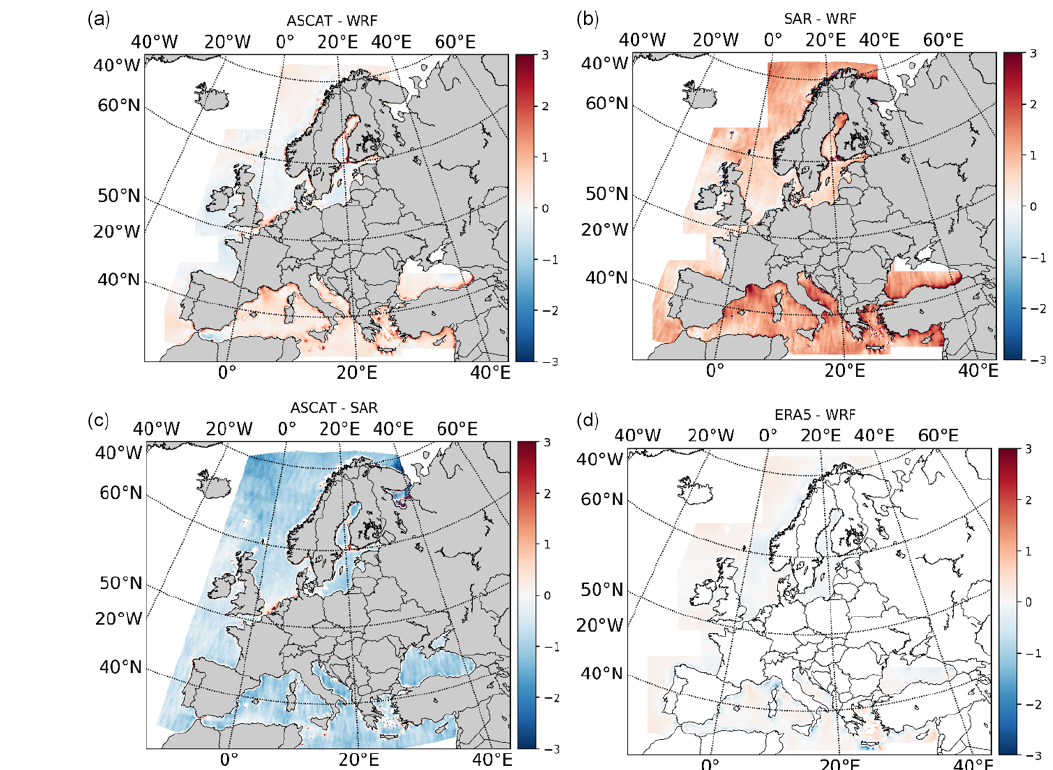
Figure 5. Comparison of mean wind speed (ms − 1 ) at 100m height: ASCAT minus WRF (a) , SAR minus WRF (b) , ASCAT minus SAR (c) , and ERA5 minus WRF (d) .